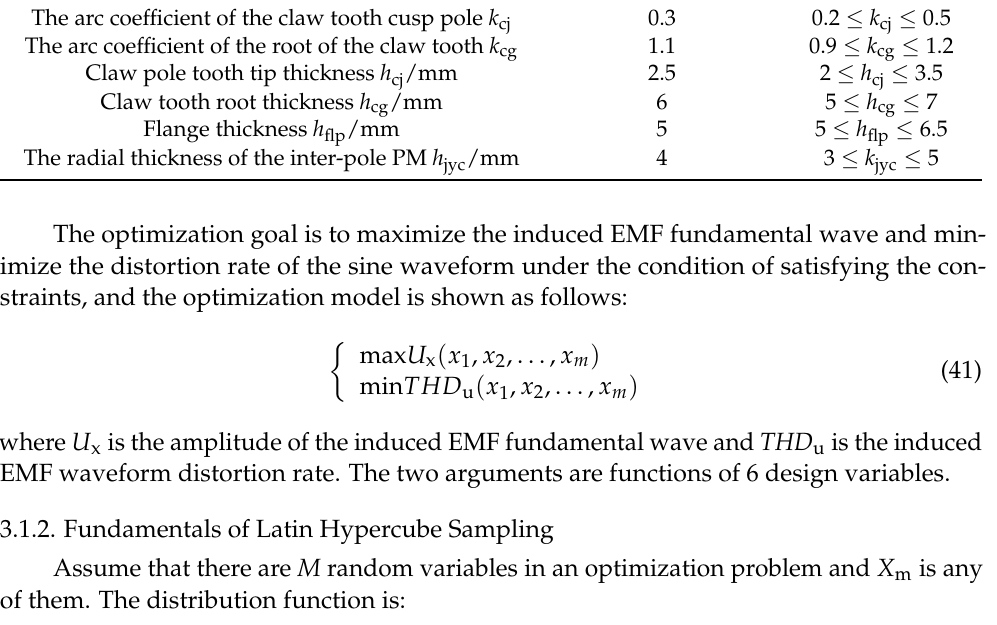
Table 1. Optimization constraints for each design variable. Design Variables Initial Value Constraints The arc coefficient of the claw tooth cusp pole k cj 0.3 0.2 ≤ k cj ≤ 0.5 The arc coefficient of the root of the claw tooth k cg 1.1